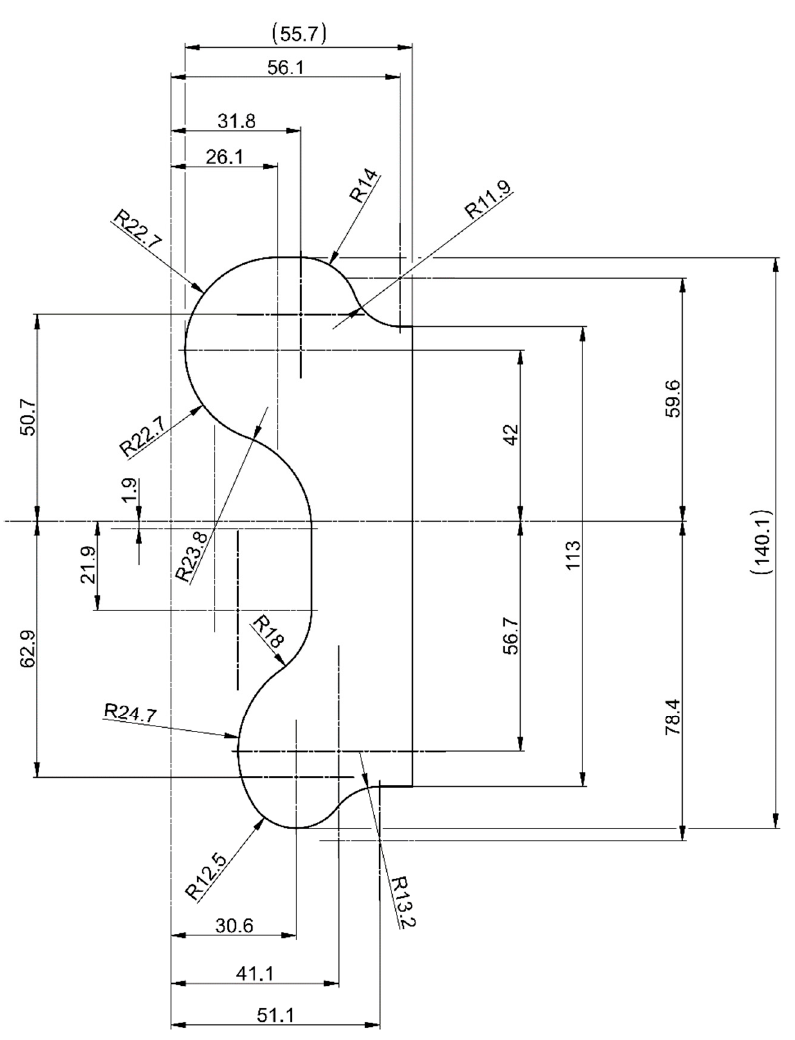
Figure A1. Technical drawing of the machined training/testing workpiece.